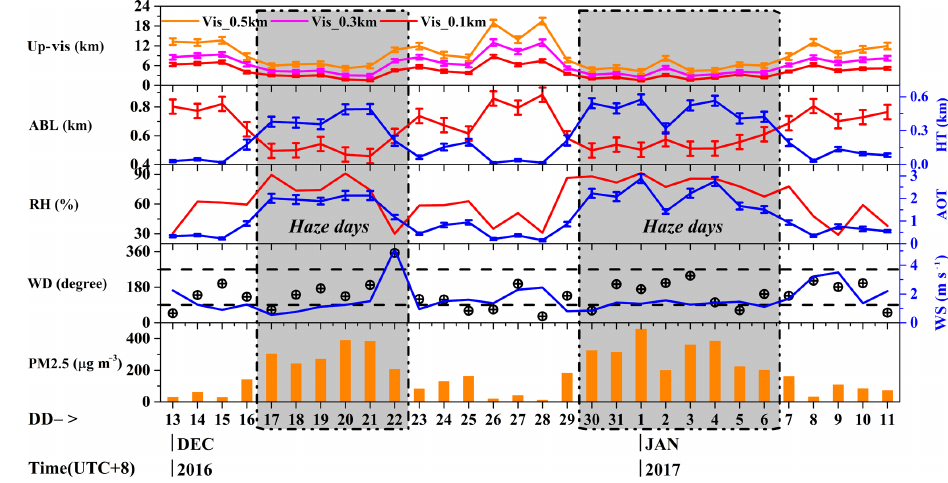
Figure 6. Daily variation of multi-platform data during successive haze episodes in the northwest of downtown